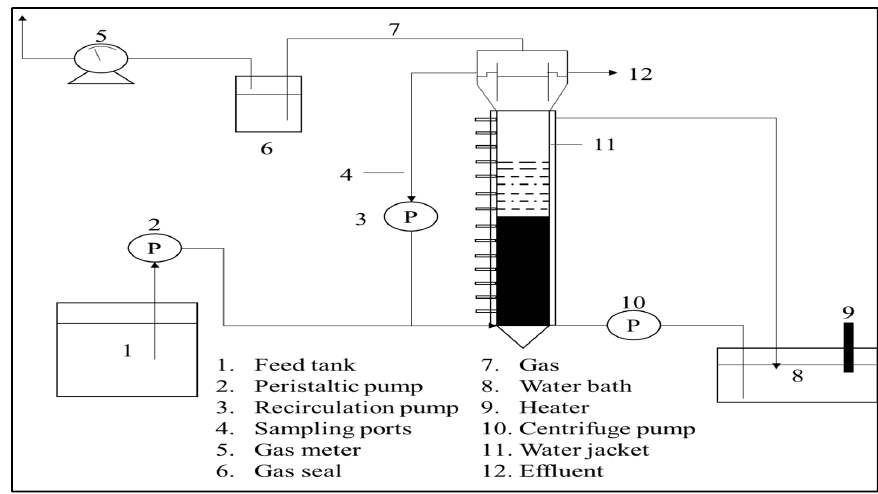
Figure 5. Schematic diagram of the two-stage UASB system. Adapted with permission from ref. [51]. Copyright 1996 Elsevier.